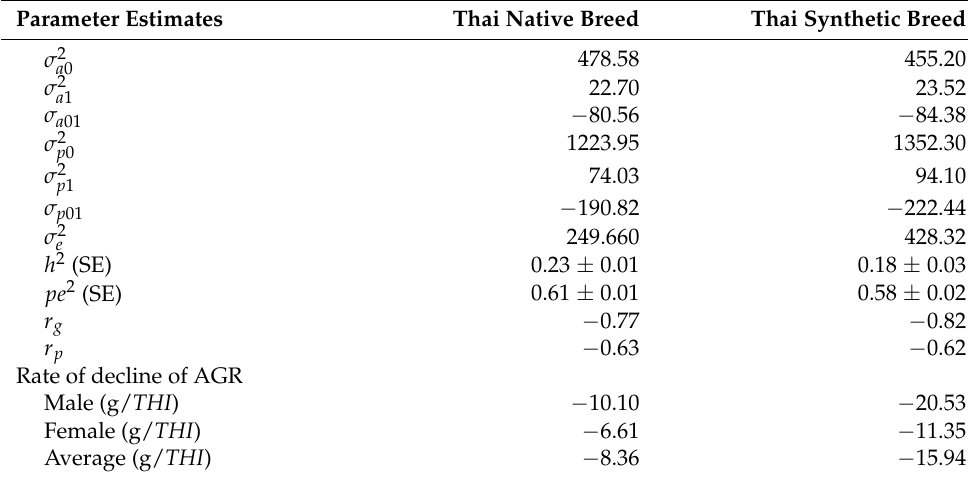
Table 3. Variance components and genetic parameters of the absolute growth rate (AGR) using the Gompertz function in purebred Thai native and Thai synthetic chickens at the temperature-humidity index ( THI ) of